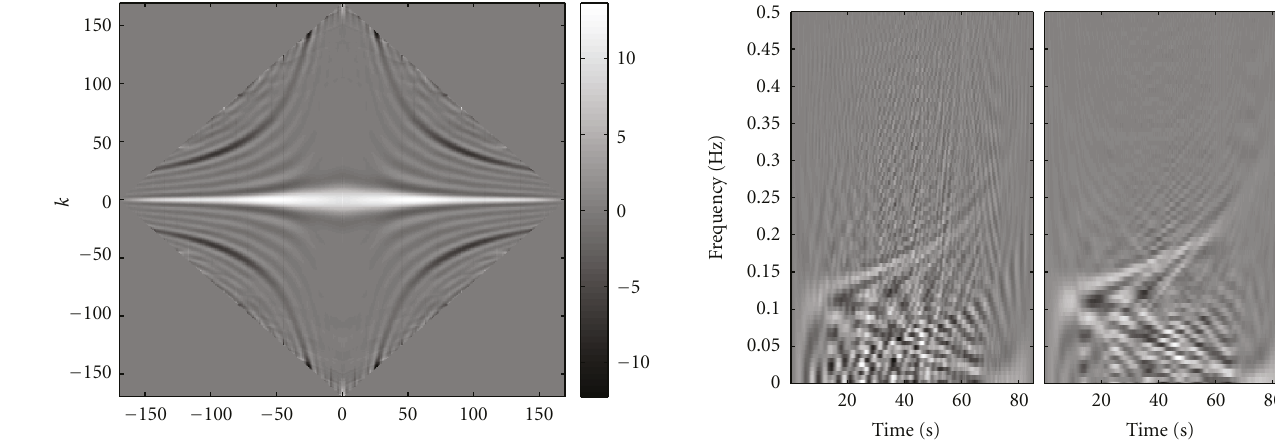
Figure 5: The MSE optimal kernel function for the family of enveloped chirp processes.